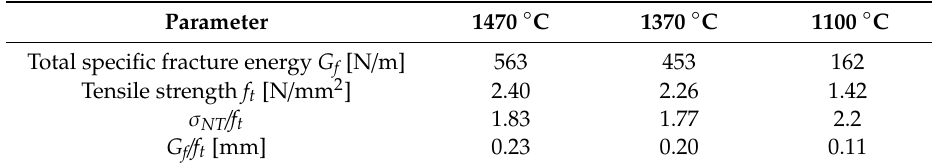
calculated from ABAQUS simulations.